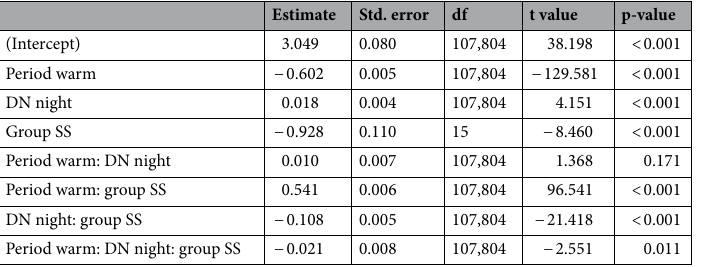
Table 2. Results of the linear mixed effects model testing the effect of period (warm and cold), day/night time (DN), and group ( SS shallow/shallow, DS deep/shallow) on the fish depth.